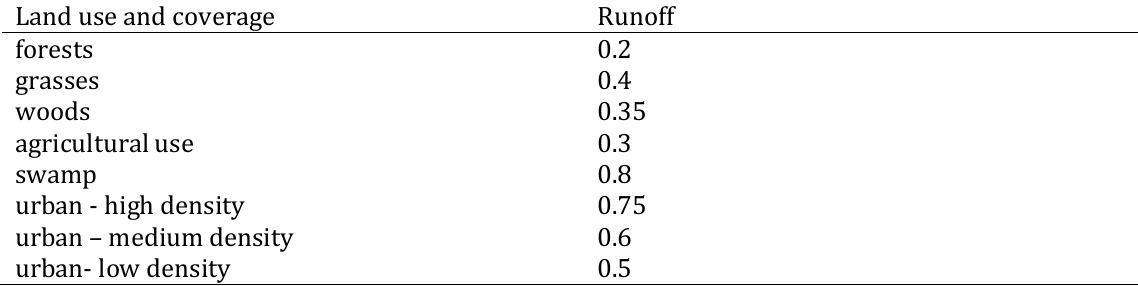
Table A1.1. Runoff values used for the study area.